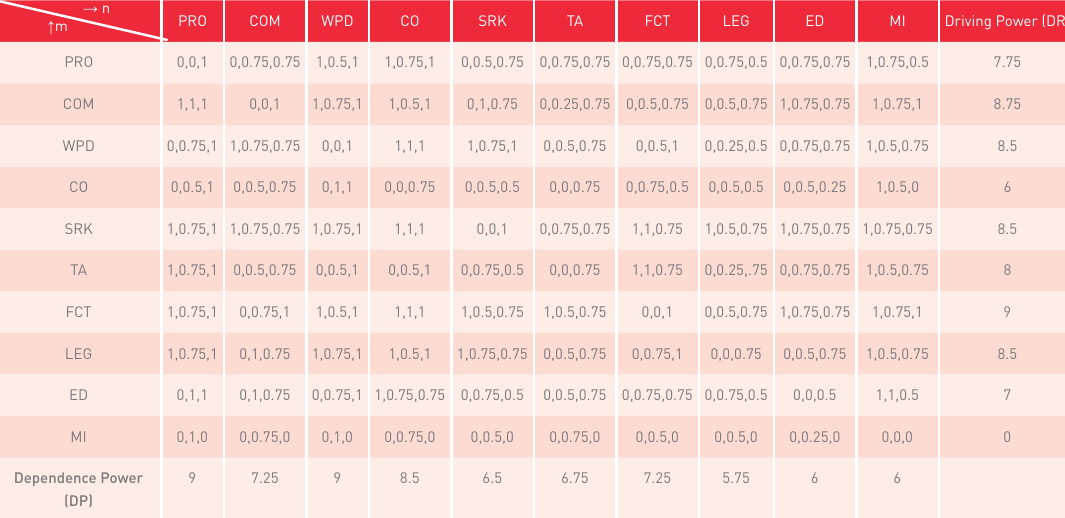
Table 8. Integrated Matrix of (Binary Direct Reachability Matrix, Fuzzy Direct Reachability Matrix and Stabilized Matrix ) for barrier variables influencing IM